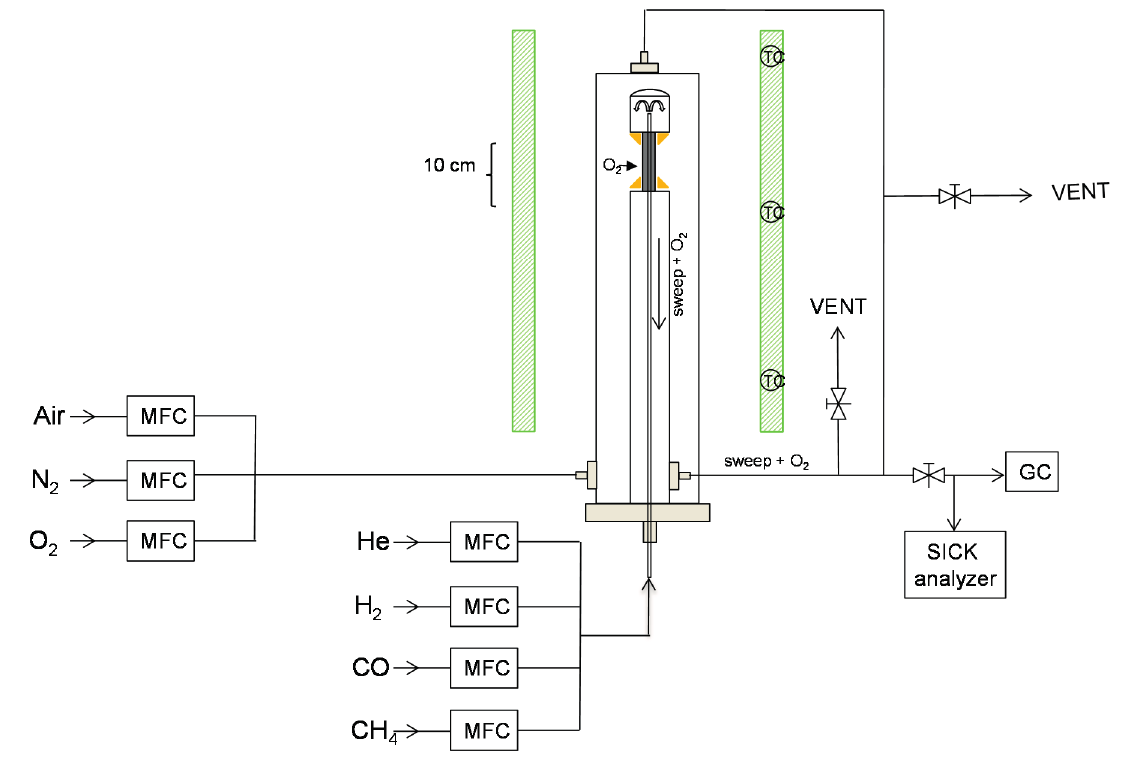
Figure 2. Layout of the experimental setup used for the permeation test. Membrane length: 10 cm, membrane tube outer diameter: 3.5 mm, membrane thickness: 0.5